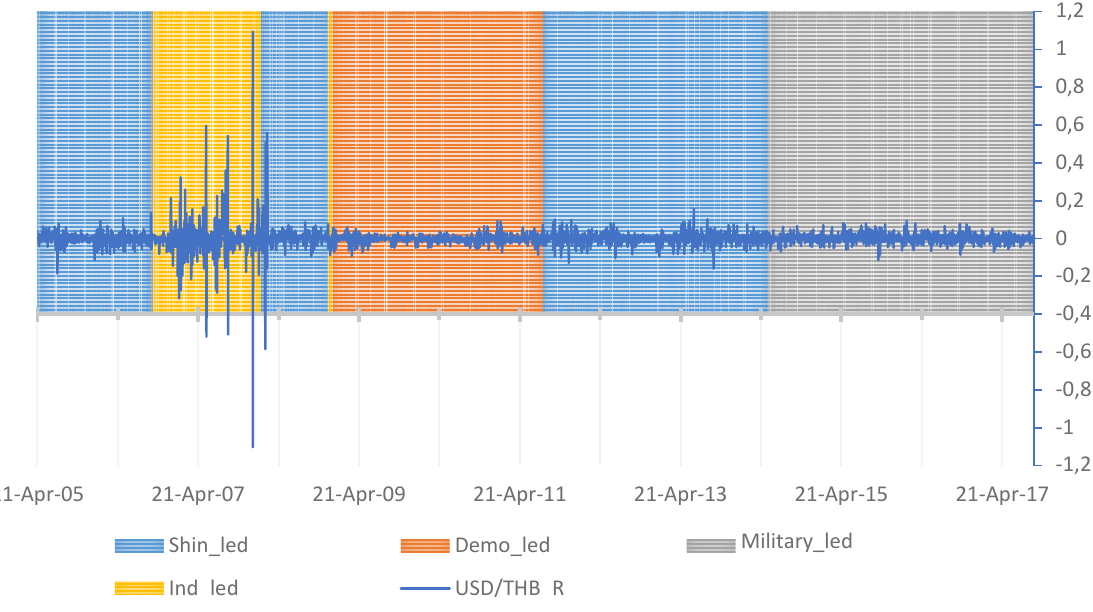
Figure 1. Thai Government and returns of USD/THB